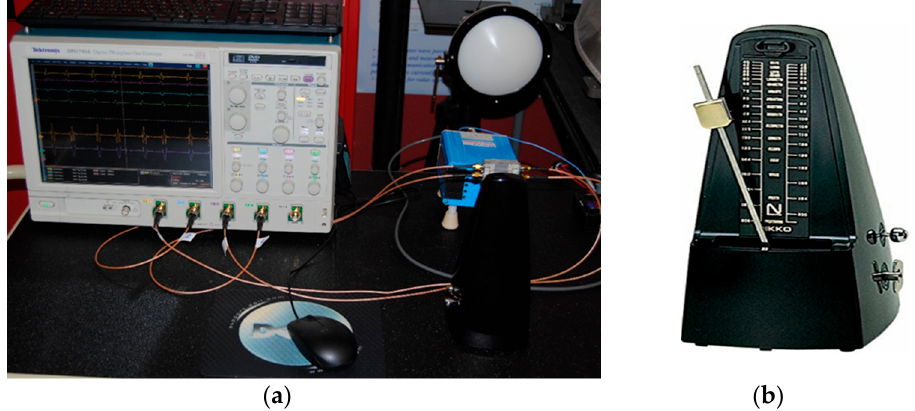
Figure 52. E-band radar sensor test-bench for metronome experiment: ( a ) overall set-up; ( b ) metronome.